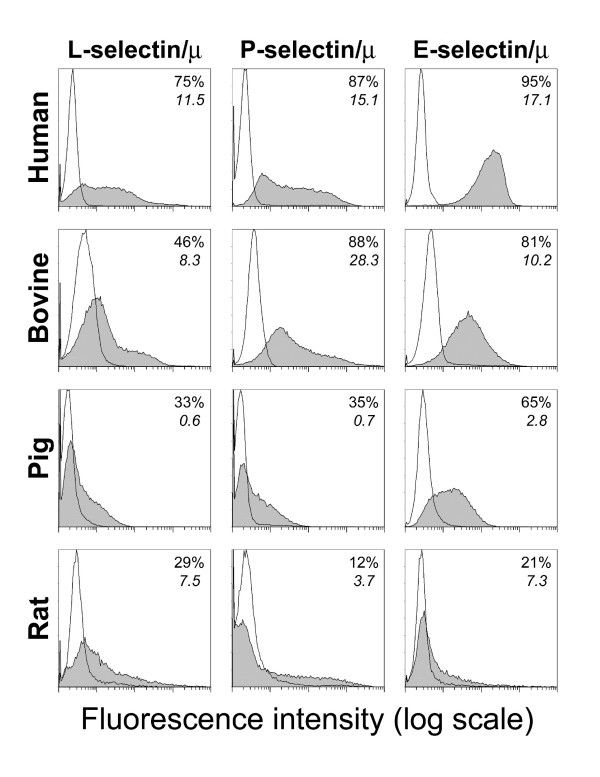
Human L-, P- or E-selectin/μ chimeras bind to human, bovine, pig or rat neutrophils. Neutrophils were incubated with saturating concentrations of human L-, P- or E-selectin/μ chimera (filled histogram). Chimera binding was abrogated by 10 mM EDTA (open histogram). The percentage of positive cells and the mean fluorescence intensity are indicated in each histogram. Histograms are representative of 2–3 experiments.